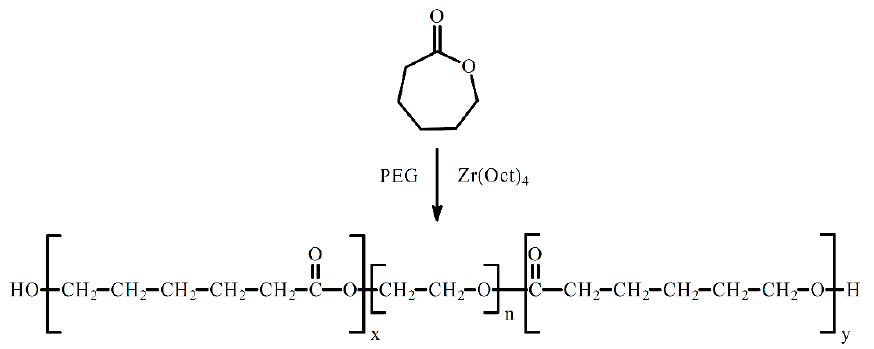
Scheme 1. Ring-opening polymerization of ε -caprolactone (CL) using zirconium(IV) octoate (Zr(Oct) 4 ) and poly(ethylene glycol) 200 (PEG 200).